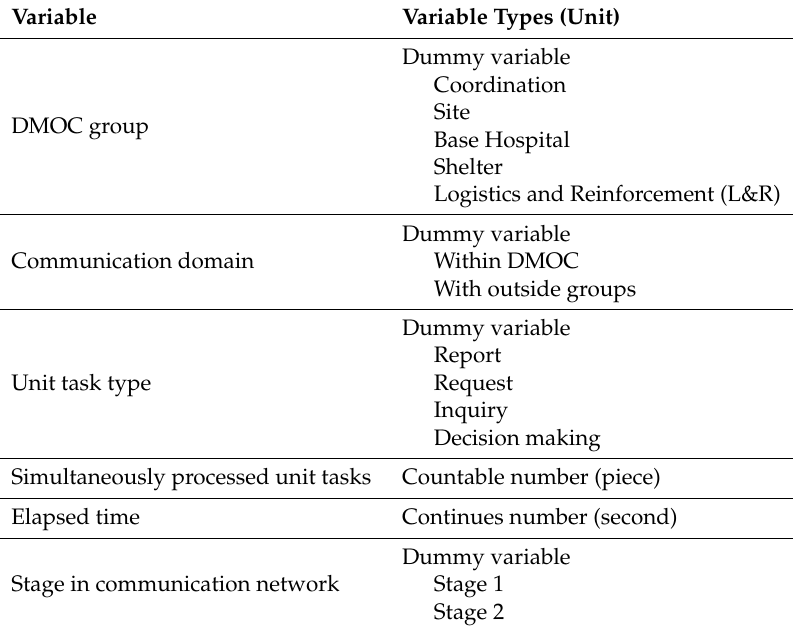
Table 2. Independent variables in multiple regression